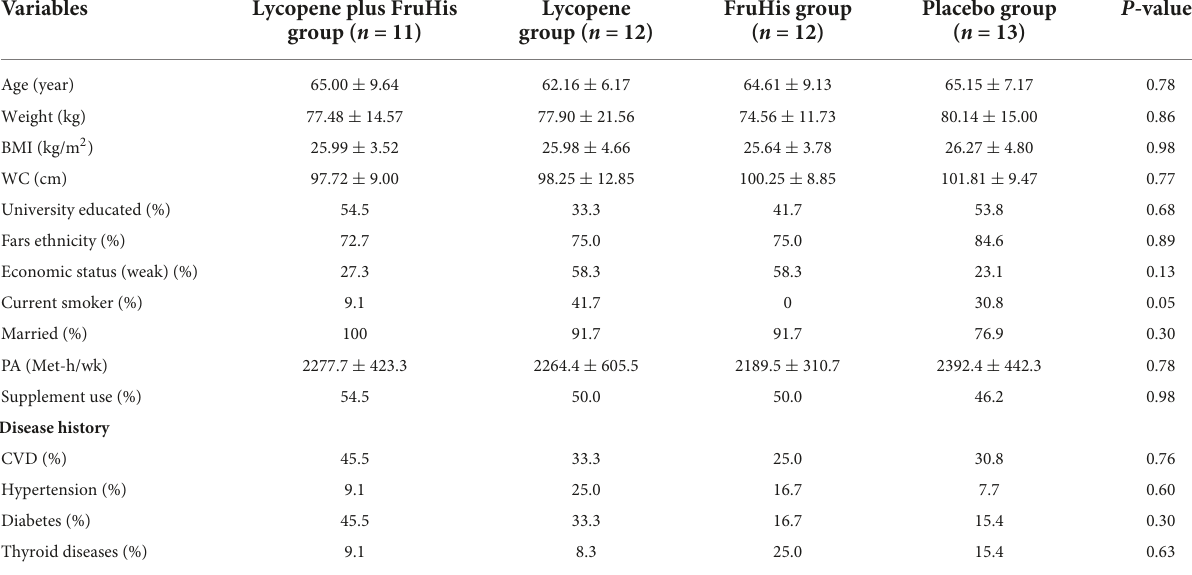
TABLE 1 Baseline characteristics of participants in the intervention groups.